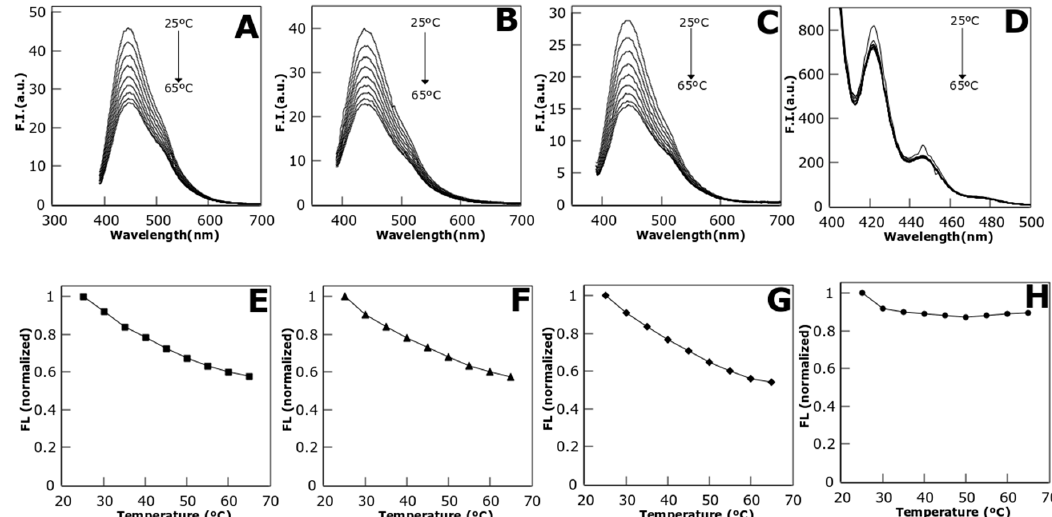
Figure 3. CTPR-templated metal NCs emission spectra under a temperature gradient from 25 °C to 65 °C (upper row) for C3_cys-CuNCs ( A ); C3_cys-AgNCs ( B ); C3_cys-AuNCs ( C ); and anthracene, as reference molecule ( D ). Normalized fluorescence intensity vs. temperature (lower row) for C3_cys-CuNCs ( E ); C3_cys-AgNCs ( F ); C3_cys-AuNCs ( G ); and anthracene ( H ).